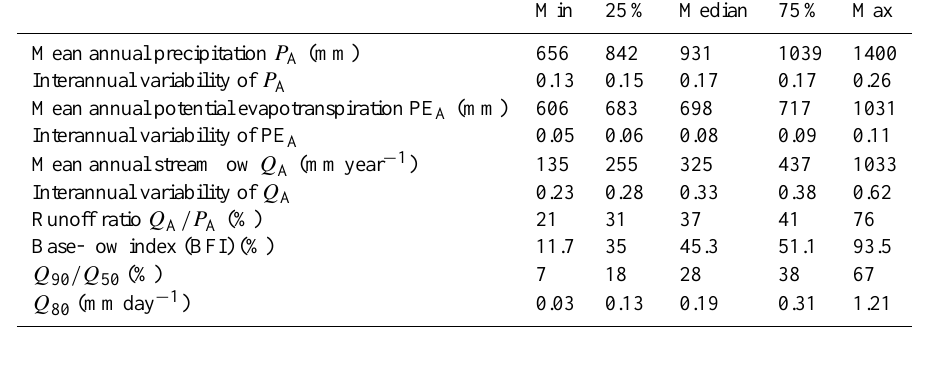
Table 2. Percentiles of the distribution of a few climatic and hydrological characteristics of the 21 selected catchments. Interannual variability values correspond to coefficients of variation calculated on the 1974–2009 period. Q 50 , Q 80 and Q 90 are respectively the 50th, 80th and 90th exceedance percentiles of the flow duration curve.